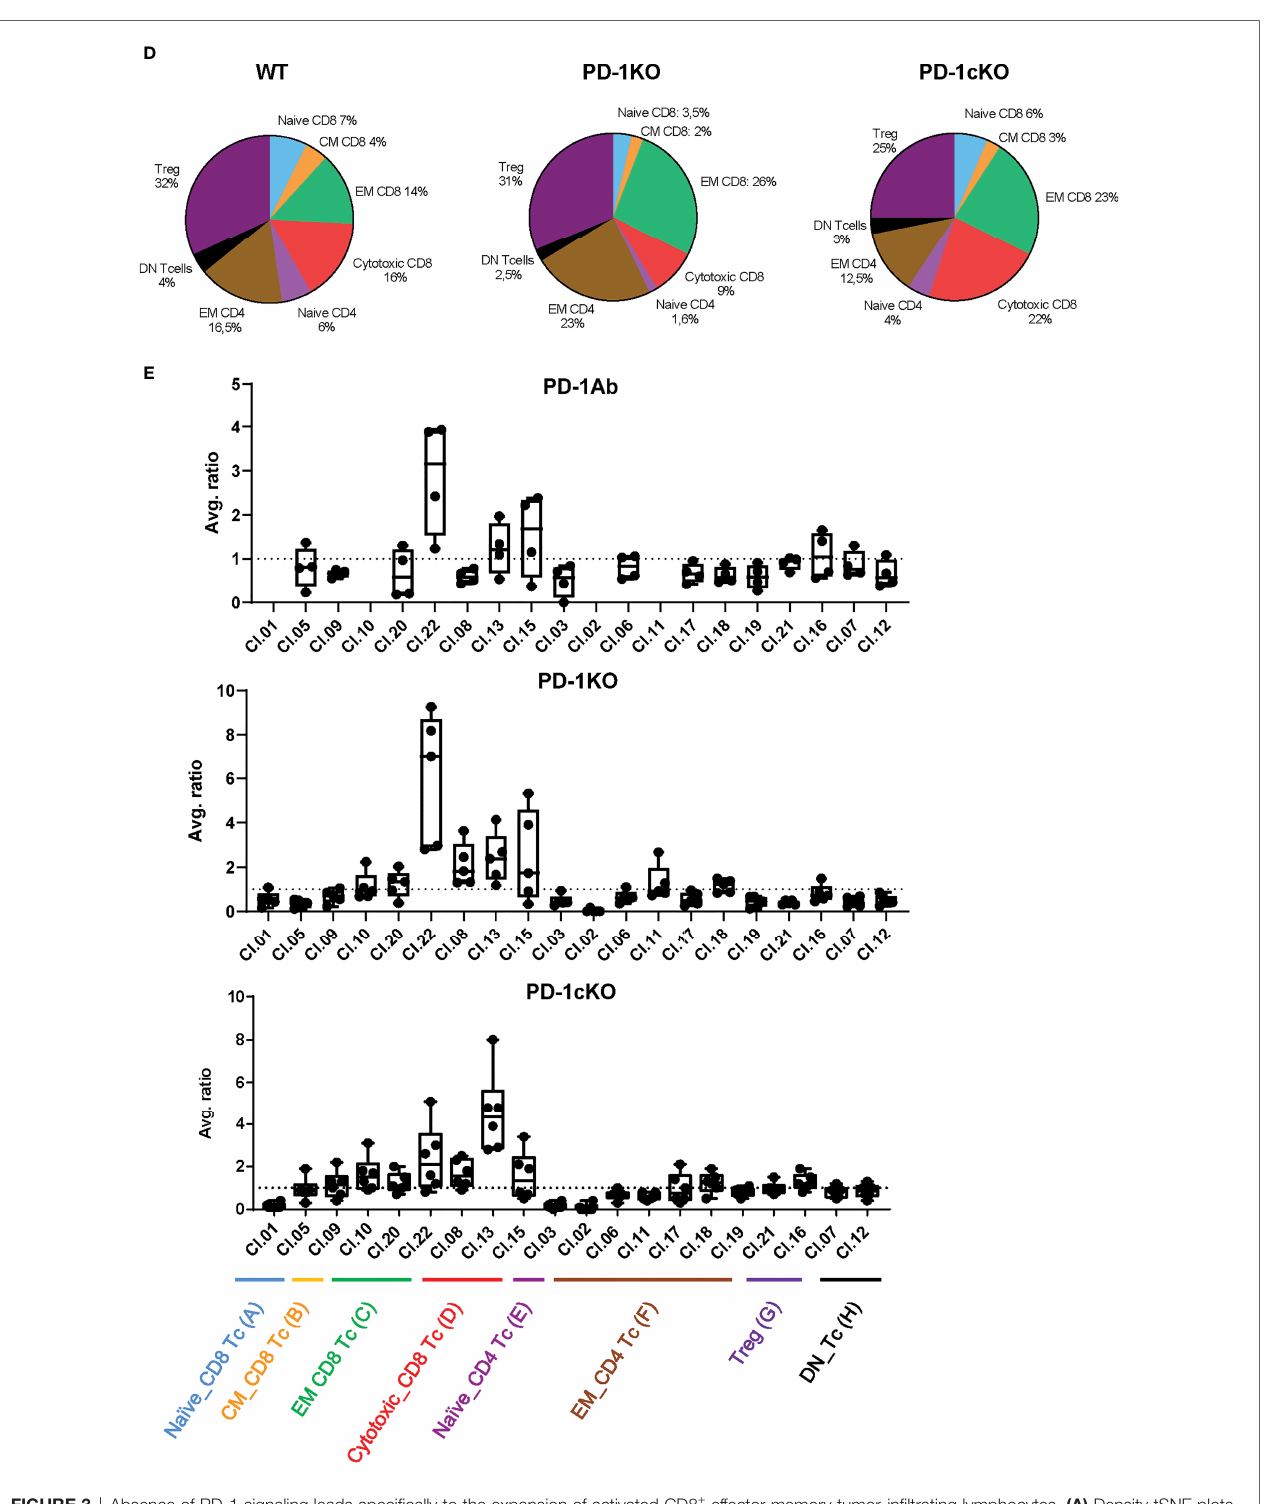
FIGURE 3 | Absence of PD-1 signaling leads speci fi cally to the expansion of activated CD8 + effector memory tumor-in fi ltrating lymphocytes. (A) Density tSNE plots of tumor-in fi ltrating lymphocytes isolated from tumors injected to WT, PD-1KO, or PD-1cKO mice (all 18 days post-implant). (B) Projection of the annotation of combined clusters at the single cell level on a tSNE plot. (C) Heatmap displaying marker expression in the designated T-cell clusters in WT mice. (D) Pie chart displaying the different T cell subsets among the tumor-in fi ltrating lymphocytes in WT, PD-1KO, or PD-1cKO mice. (E) Average ratio of the frequency of the T cell found in each R-phonograph cluster per mouse (mean + SD). The T-cell clusters labeled by their name as in (C) . Data representative of two independent experiments with n = 3 – 5 mice/experiment, group, and time